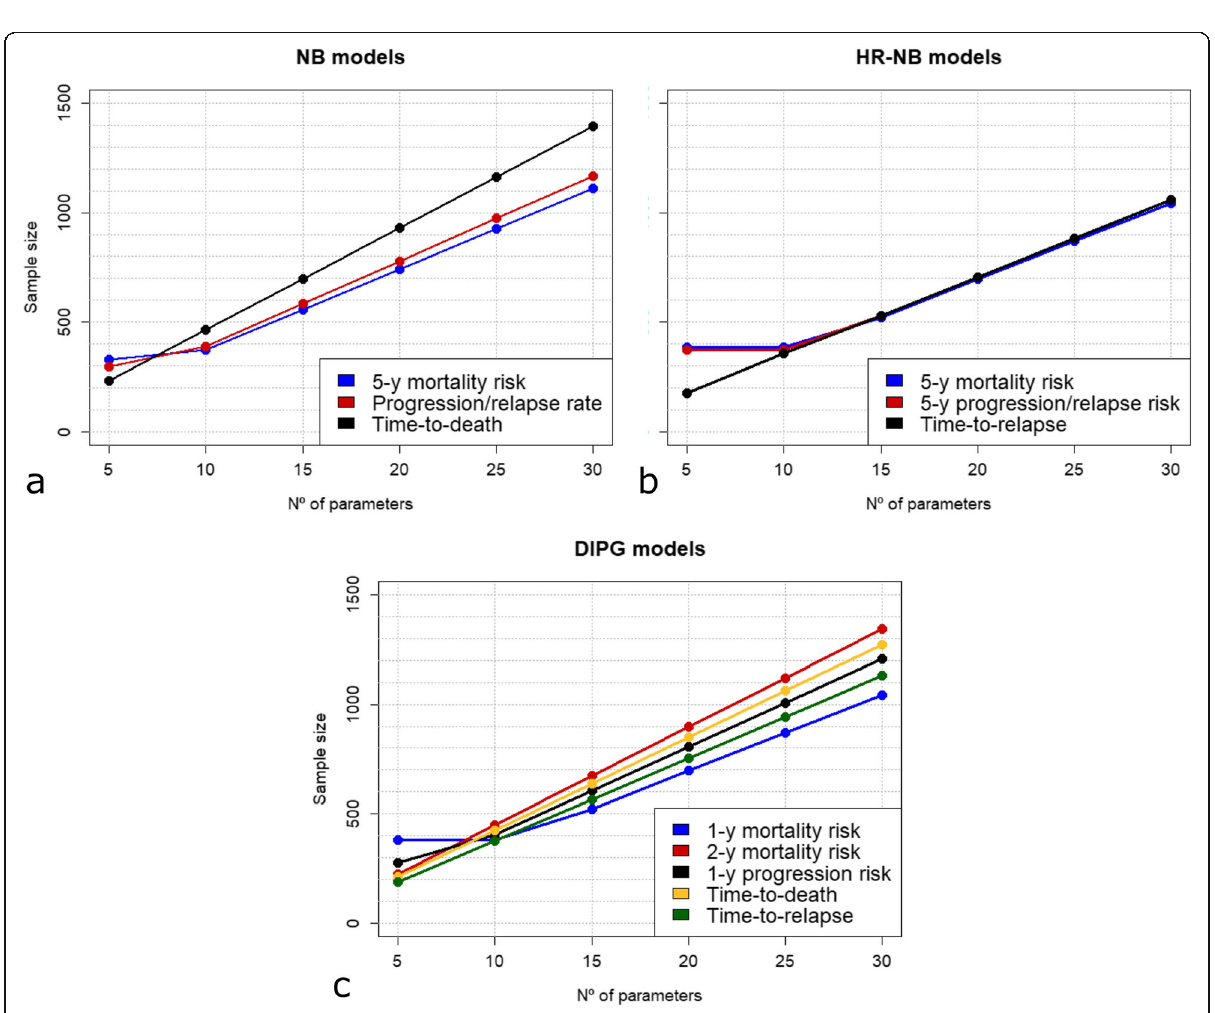
Fig. 2 Impact of the number of predictor variables on the sample size. Variability in the sample size relative to the number of predictor variables included in model development for neuroblastoma ( A ), HR neuroblastoma ( B ) and DIPG ( C ). DIPG diffuse intrinsic pontine glioma, HR high-risk, NB